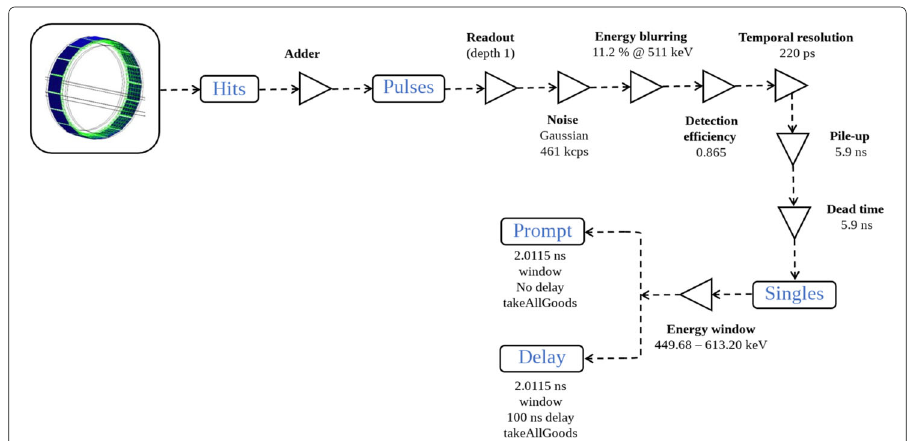
Fig. 2 Digitizer chain used in GATE